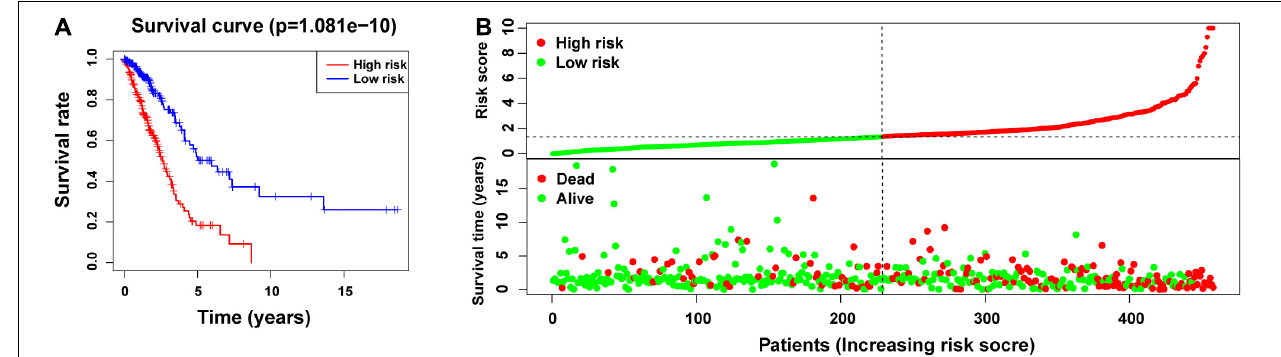
FIGURE 3 | Prognostic value of risk models based on m5C-related lncRNAs. (A) Kaplan–Meier curve showing that the overall survival of the high-risk group was lower than that of the low-risk group ( p < 0.001). (B) Risk score distribution (based on m5C-related lncRNAs prognostic signature (m5C-LPS) and survival status in patients with